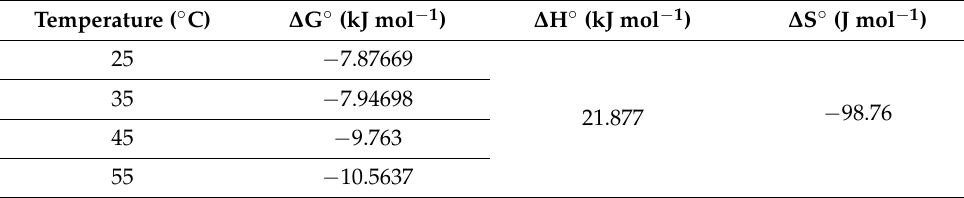
Table 5. Thermodynamic factors of the sorption of IV2R onto MWCNTs.